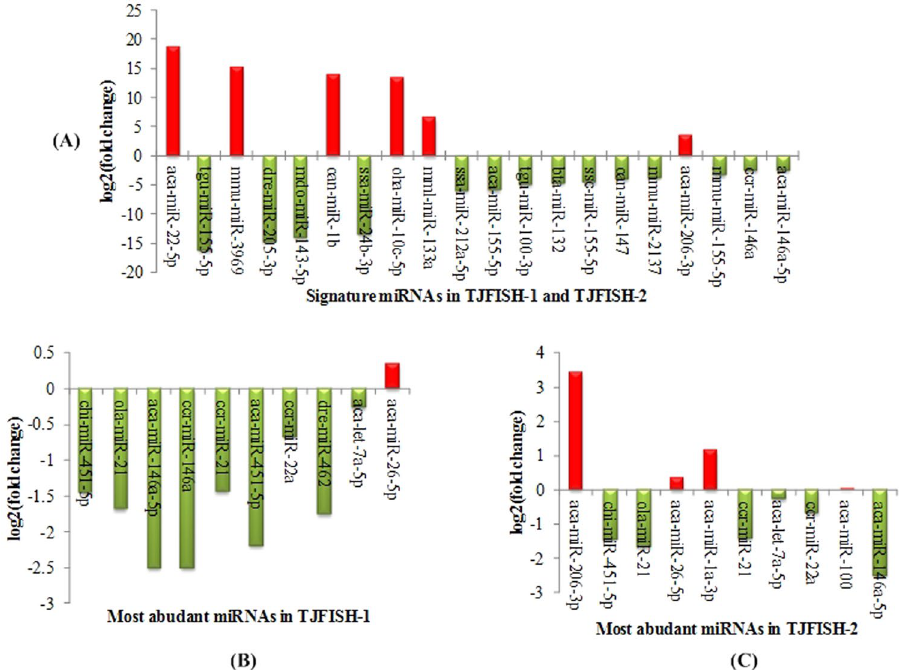
Figure 3. Expression of selected miRNAs in C. semilaevis . ( A ) Expression of 20 signature miRNAs in TJFISH-1 and TJFISH-2. ( B ) Expression of 10 most abundant miRNAs in TJFISH-1. ( C ) Expression of 10 most abundant miRNAs in TJFISH-2. Red and green colors indicate up and down regulation of miRNAs in TJFISH-2 compared to TJFISH-1, respectively.